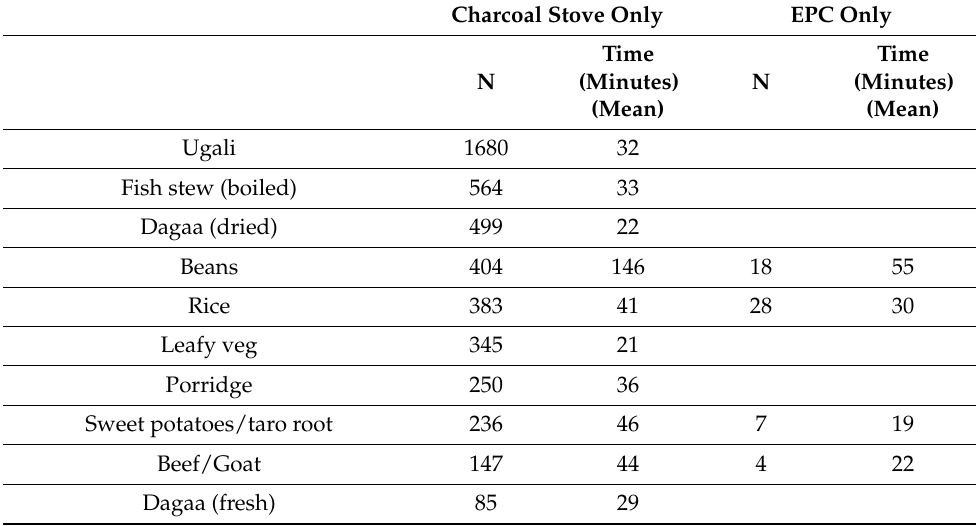
Table 11. Time taken to cook dishes using charcoal stove and EPC only—top 10 dishes (cooking diaries Phase 1 and 2).